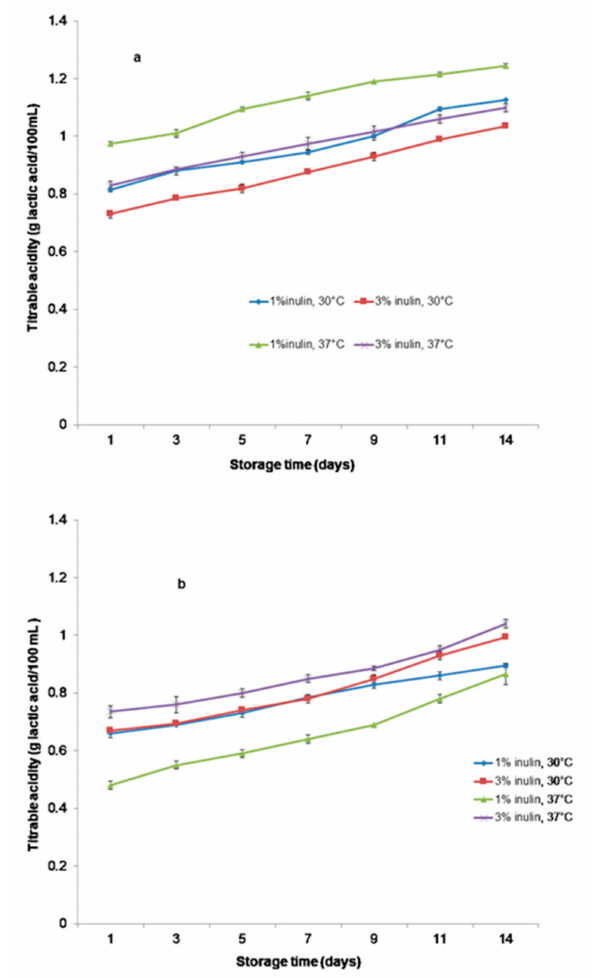
Figure 6. Variations in titratable acidity of beverages during storage at 4 ◦ C. ( a ) Samples with SBS; ( b ) Samples with